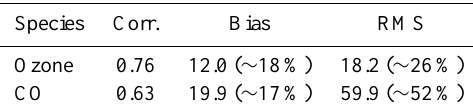
Table 5. Correlation coefficients (2nd column), biases (3rd column) and root-mean square (4th column) in µgm − 3 and in % (in brack- ets) between ground based station observations and MOCAGE na- ture run for France from 1 July 2009 to 31 August 2009 computed on an hourly mean basis. Species